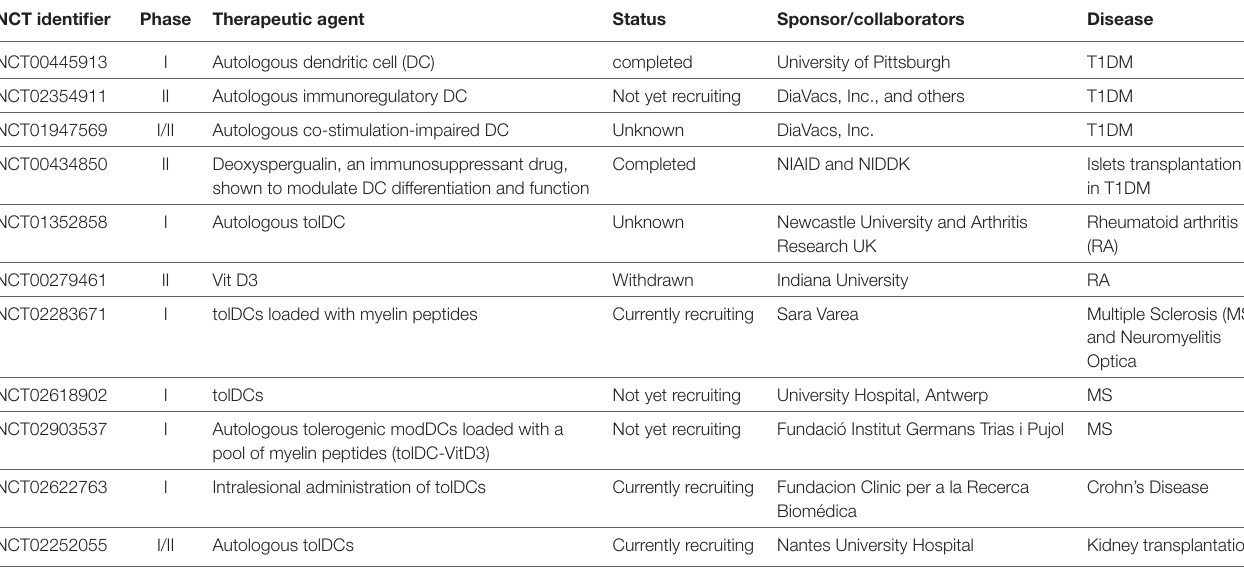
Table 3 | Tolerogenic DCs (tolDCs)-based clinical